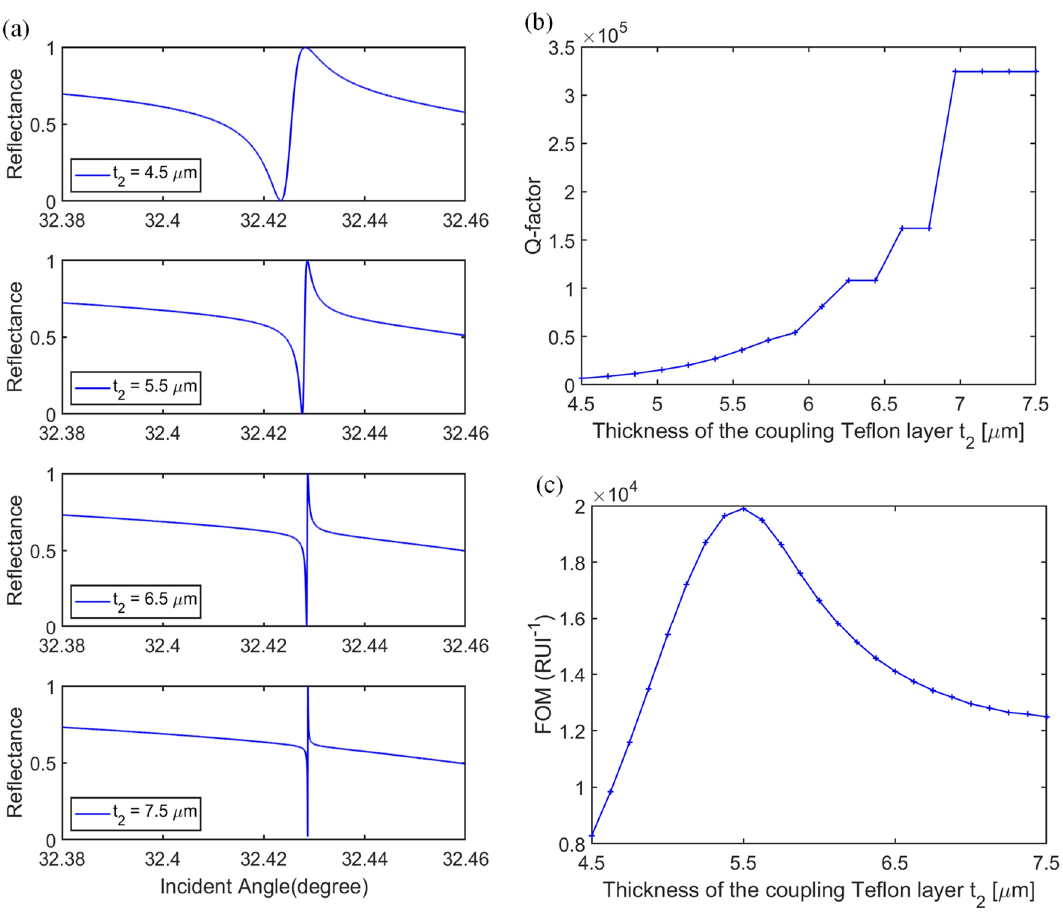
Figure 10. ( a ) ATR curves of the Fano resonance for different thicknesses of the coupling Teflon layer t 2 ; ( b ) Q -factor and ( c ) FOM as a function of the thickness of the coupling Teflon layer t 2 . The effect of the thickness of the Si layer t 3 on the Fano resonance was also